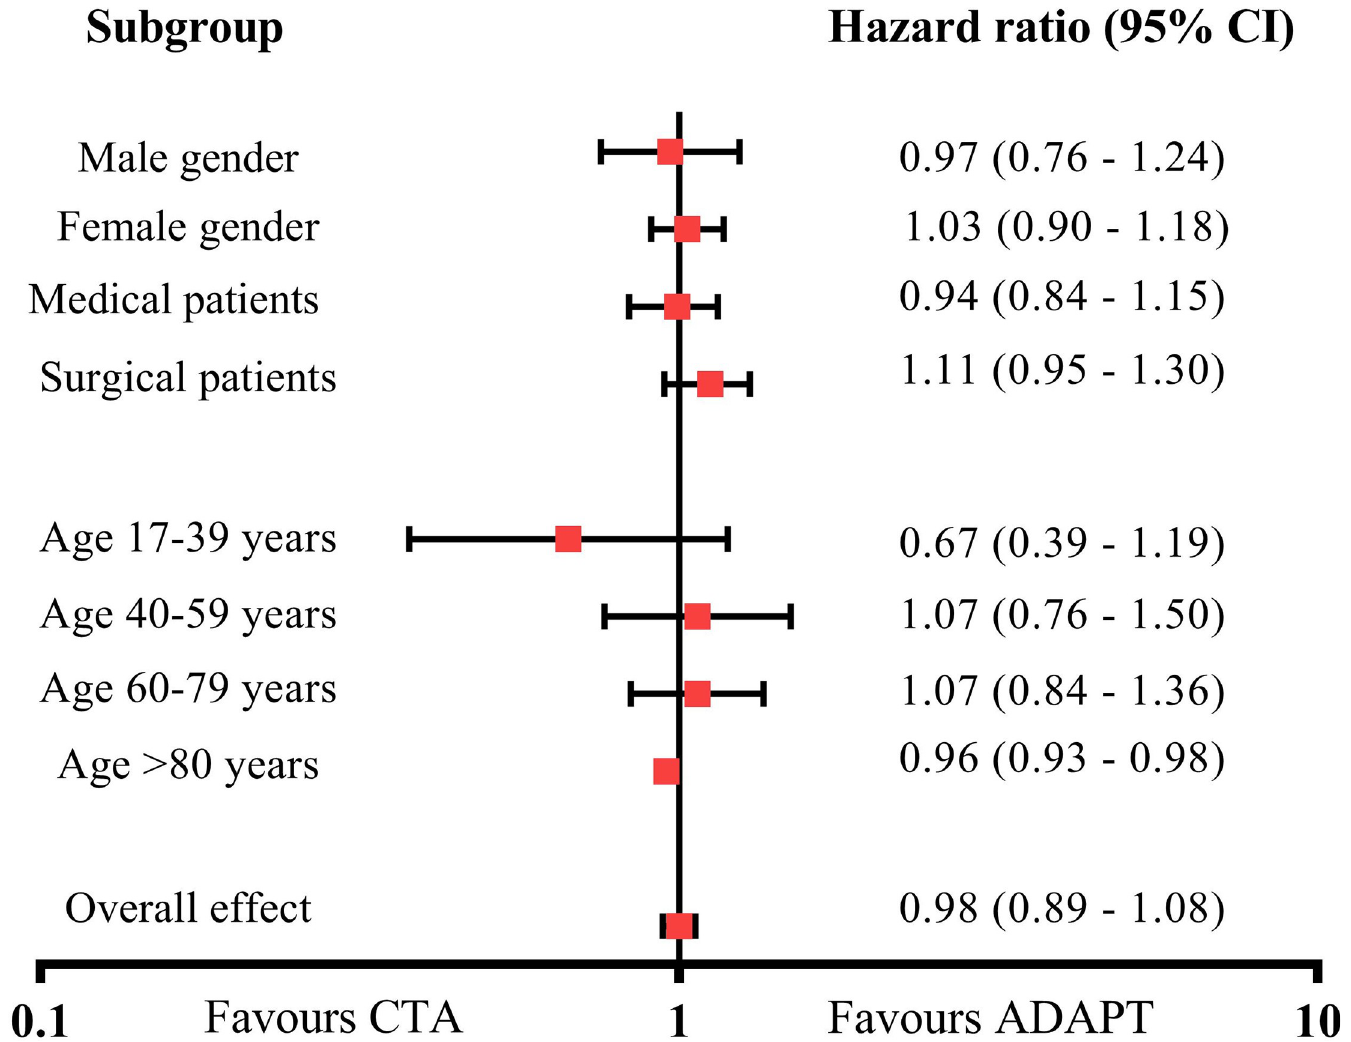
Fig 4. Forest plot for 30-day all-cause mortality for patients admitted to the emergency